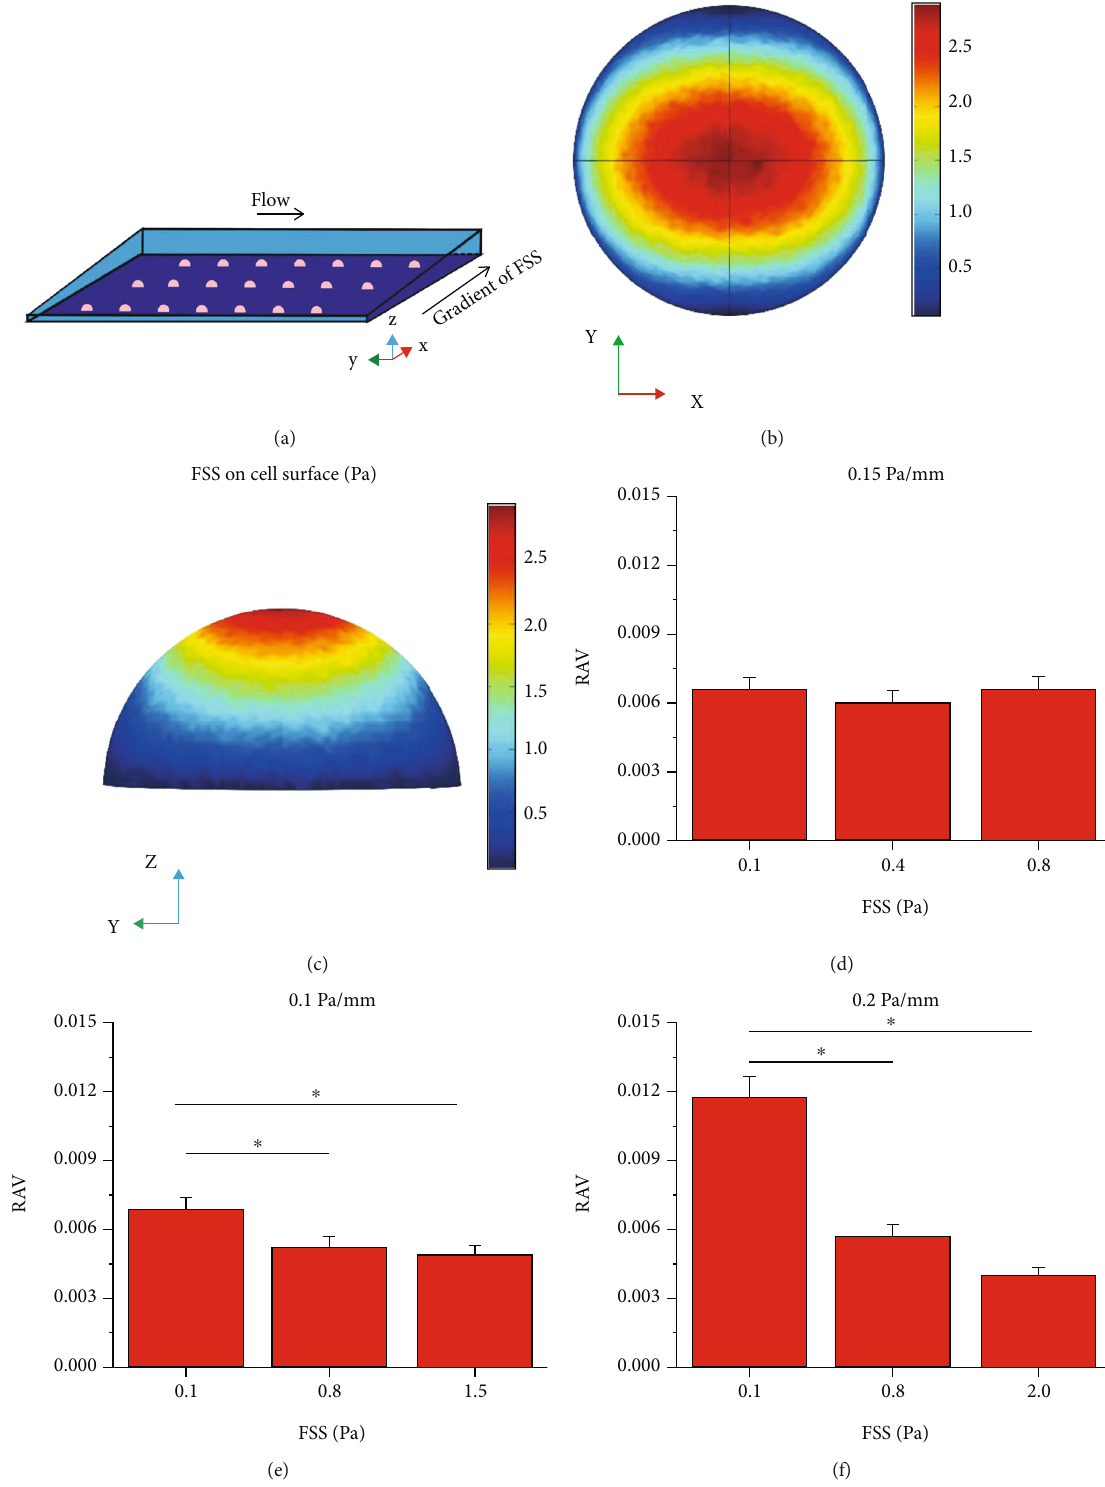
Figure 3: Average wall FSS in SHFSS and SLFSS on discretely distributed cells along fl ow direction. (a) Schematic of the cells arranged on the bottom plate with di ff erent locations. (b) Top and (c) side views of wall FSS on cell surface. (d – f) Ratios of average value (RAV) of local FSS in SHFSS relative to that in SLFSS; ∗ p < 0 : 05